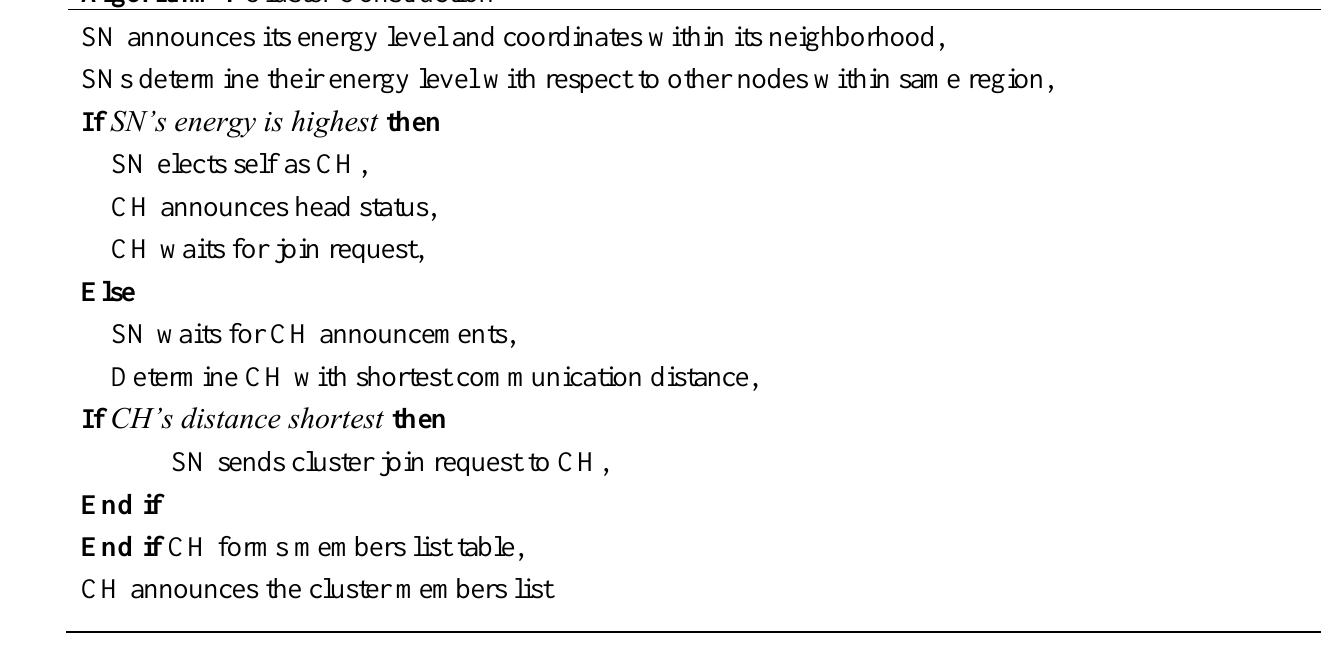
Algorithm 1 Cluster